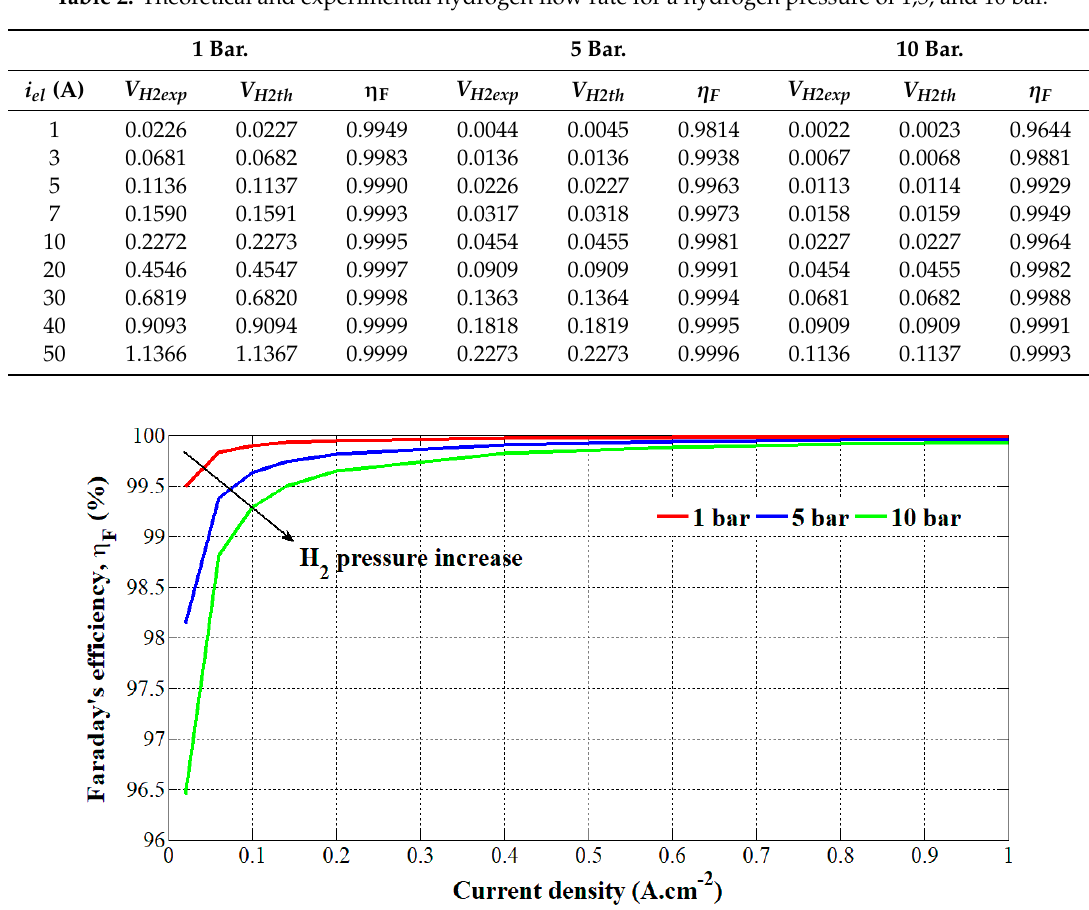
Figure 5. Obtained Faraday’s efficiency based on current density and hydrogen pressure change.